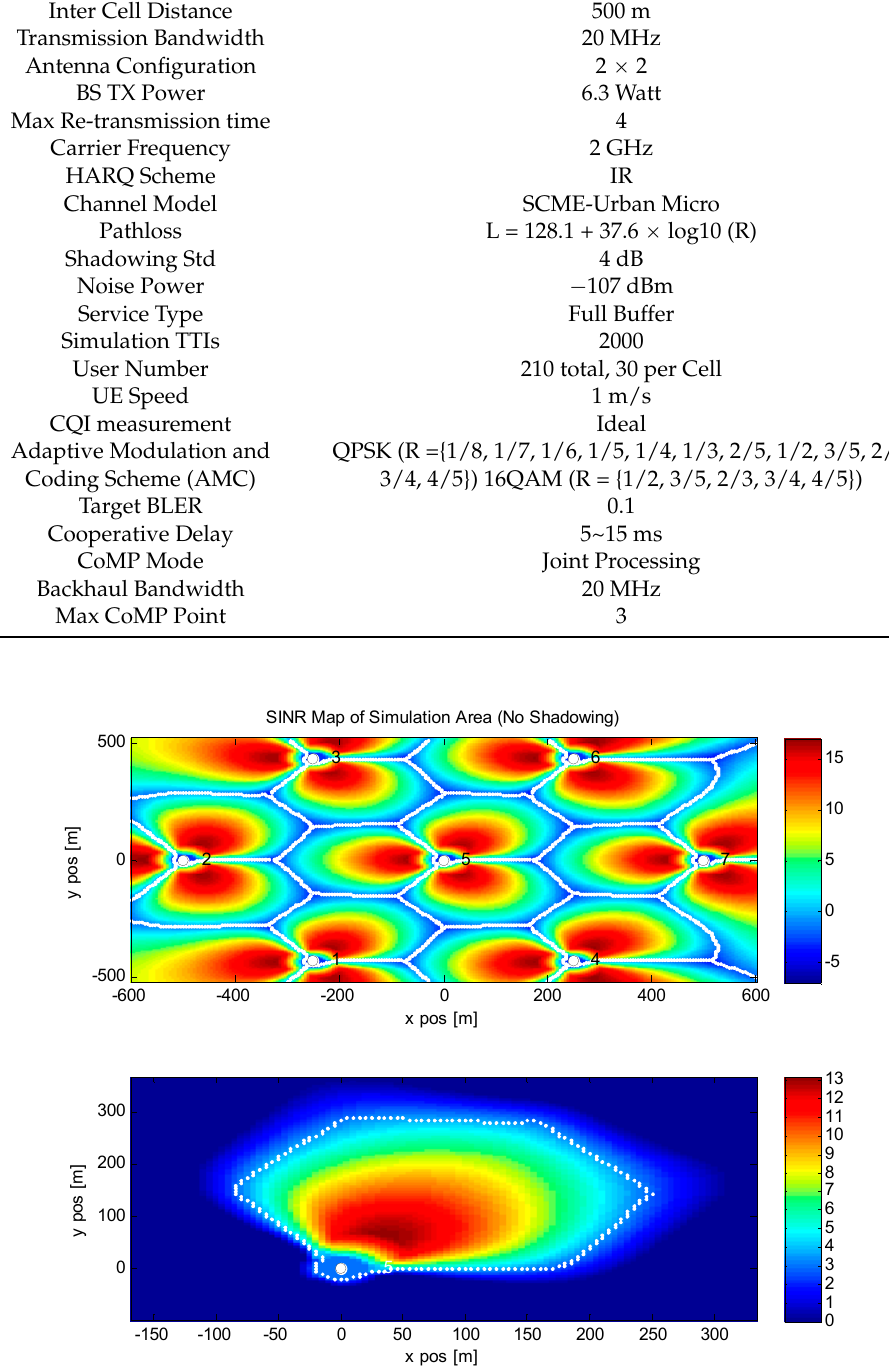
Figure 5. SINR map with shadowing of our simulated area. Shadow fading is considered in this figure, buildings, trees and other loose impediments will affect the radius of the wireless signal. In Figure 6, the statistical result of system average throughput for different base stations is given. The x-axis is the index of different base stations and y-axis is the average throughput in Mbps. Different colors indicate different methods. Red color represents the proposed method using our optimal backhaul resource allocation, green represents the method using equal backhaul resource